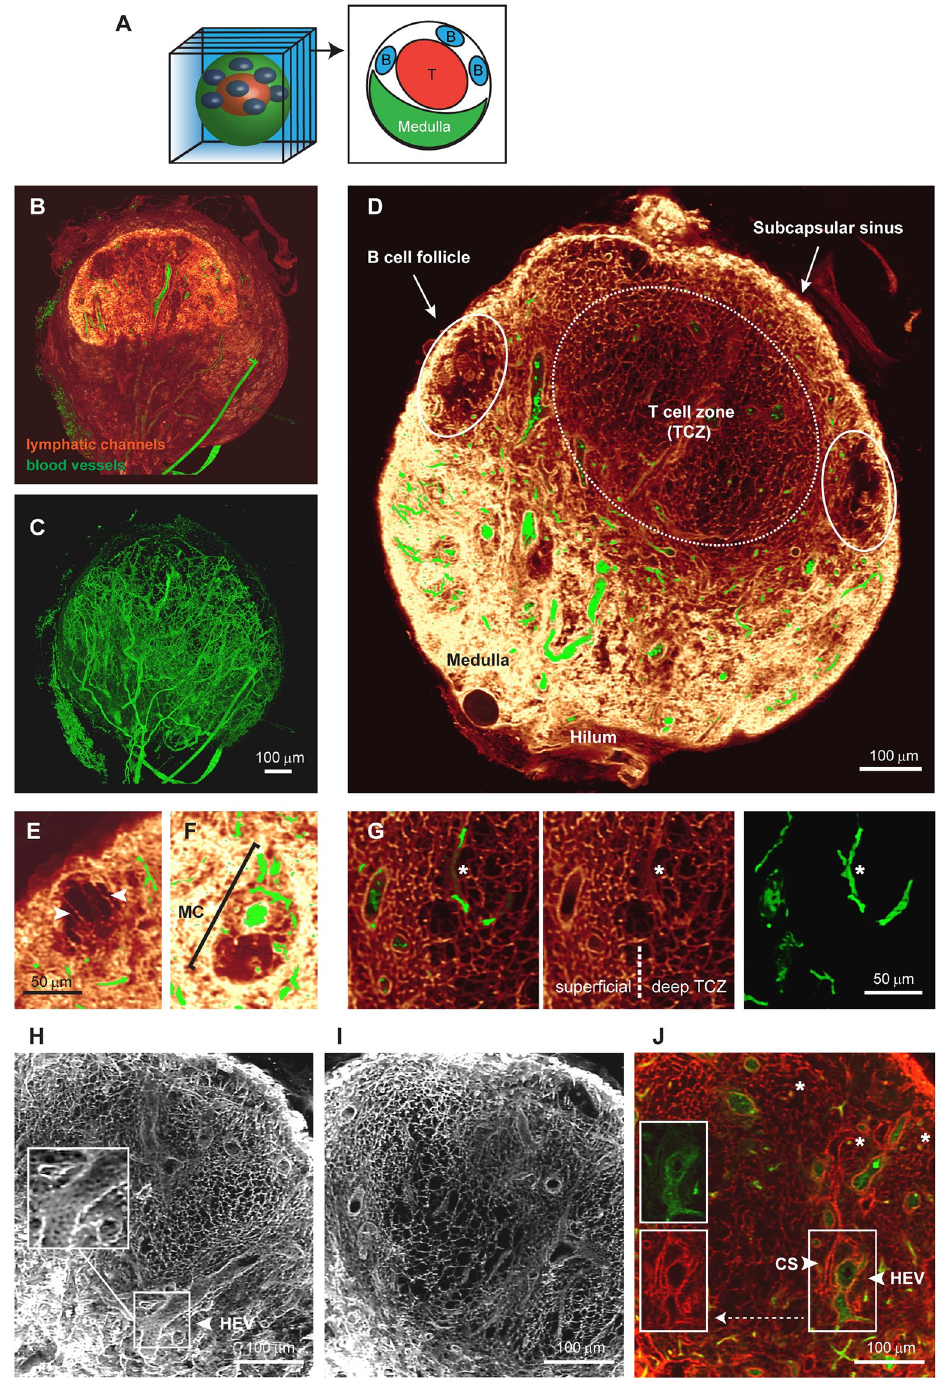
Fig 1. Detailed 3D images of the conduit network in a whole LN. EVIS imaging of an entire popliteal LN generated a 3D volume image of which interior slices can be viewed individually (A). Three-dimensional image reconstruction of the entire LN shows (B) lymphatic channels filled with the tracer molecule WGA (red glow) together with dextran- labeled blood vessels (green), or the blood vasculature alone (C). An interior view of 20- μ m thick optical sections (D— I) and a 1 μ m slice (J) permits detailed insights into the LN architecture. A cross-section of the LN displays the location of cell-specific zones (D), and close-ups reveal anatomical details, including the arrangement of long conduits descending from the SCS at the edges of a B cell follicle (arrowheads, E), an MC with a central blood vessel situated amongst the WGA-filled sinuses of the medulla (F), and the transition from dense to sparse conduit networks in